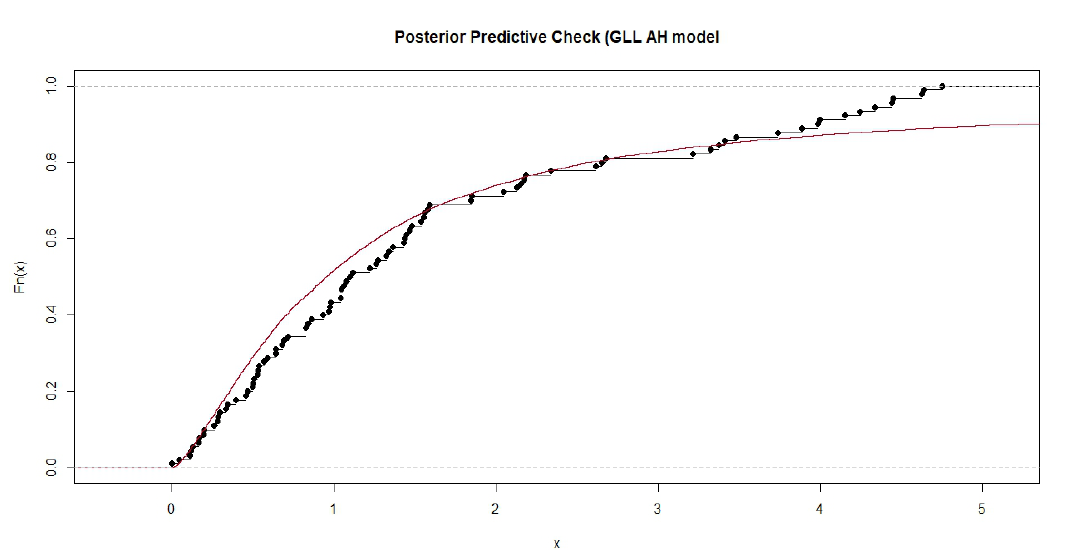
Figure 10. The empirical CDF, the dotted line and the CDF of the fitted model, the smooth curve, show that the fitted GLL–AH model predicts the future observations that are consistent with the current data.